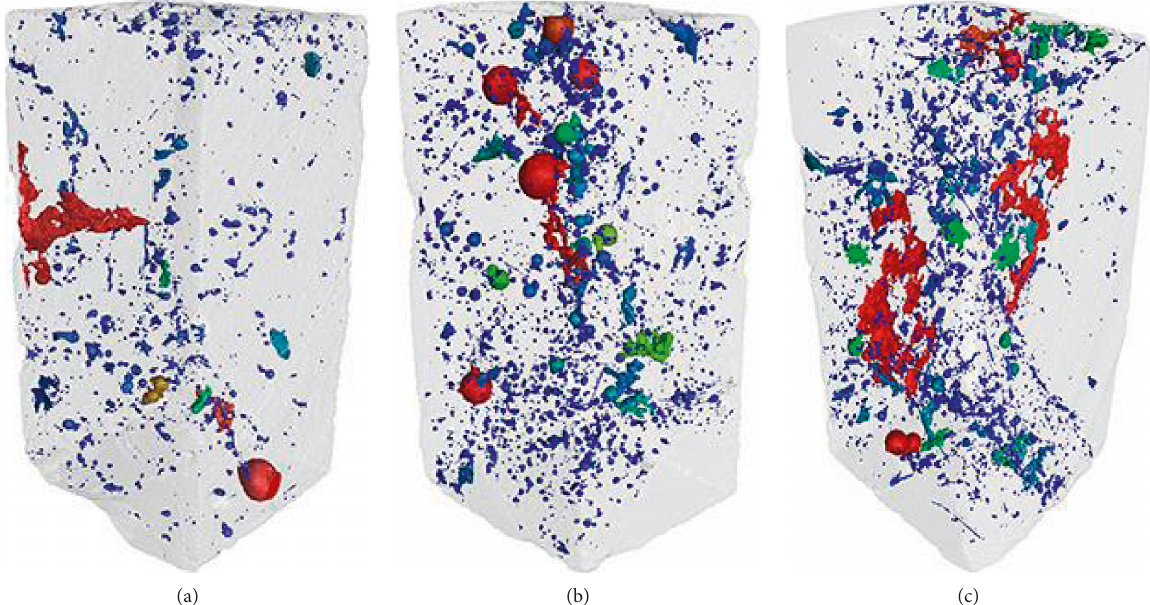
Figure 7: 3D image of dispersion of pores: (a) the sample with 0.10% volume fraction of fibers; (b) the sample with 0.20% volume fraction of fibers; (c) the sample with 0.30% volume fraction of fibers.